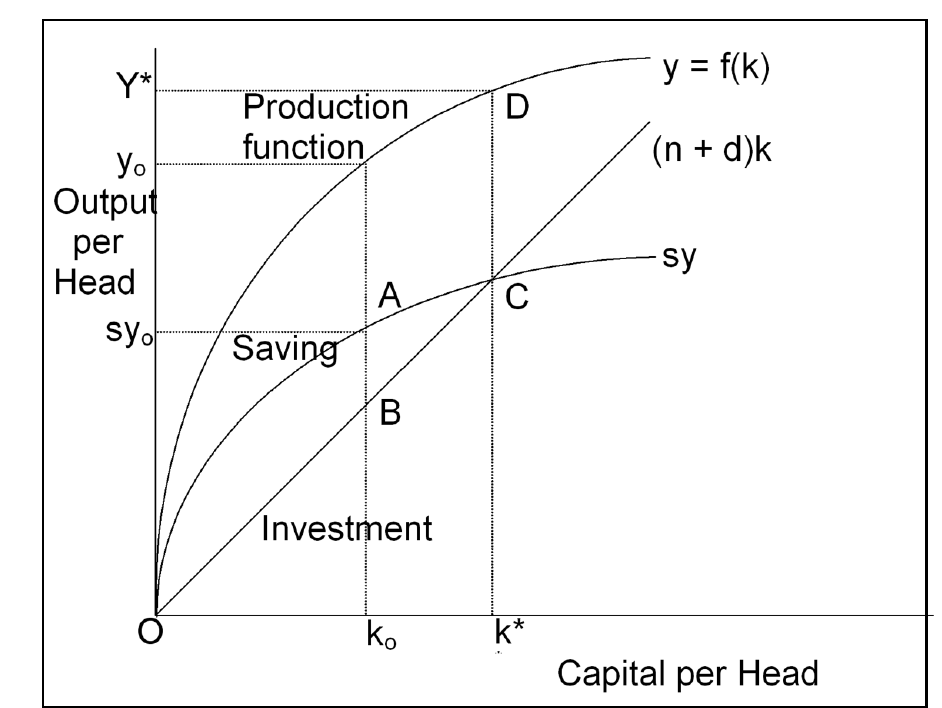
Figure 3. Steady state